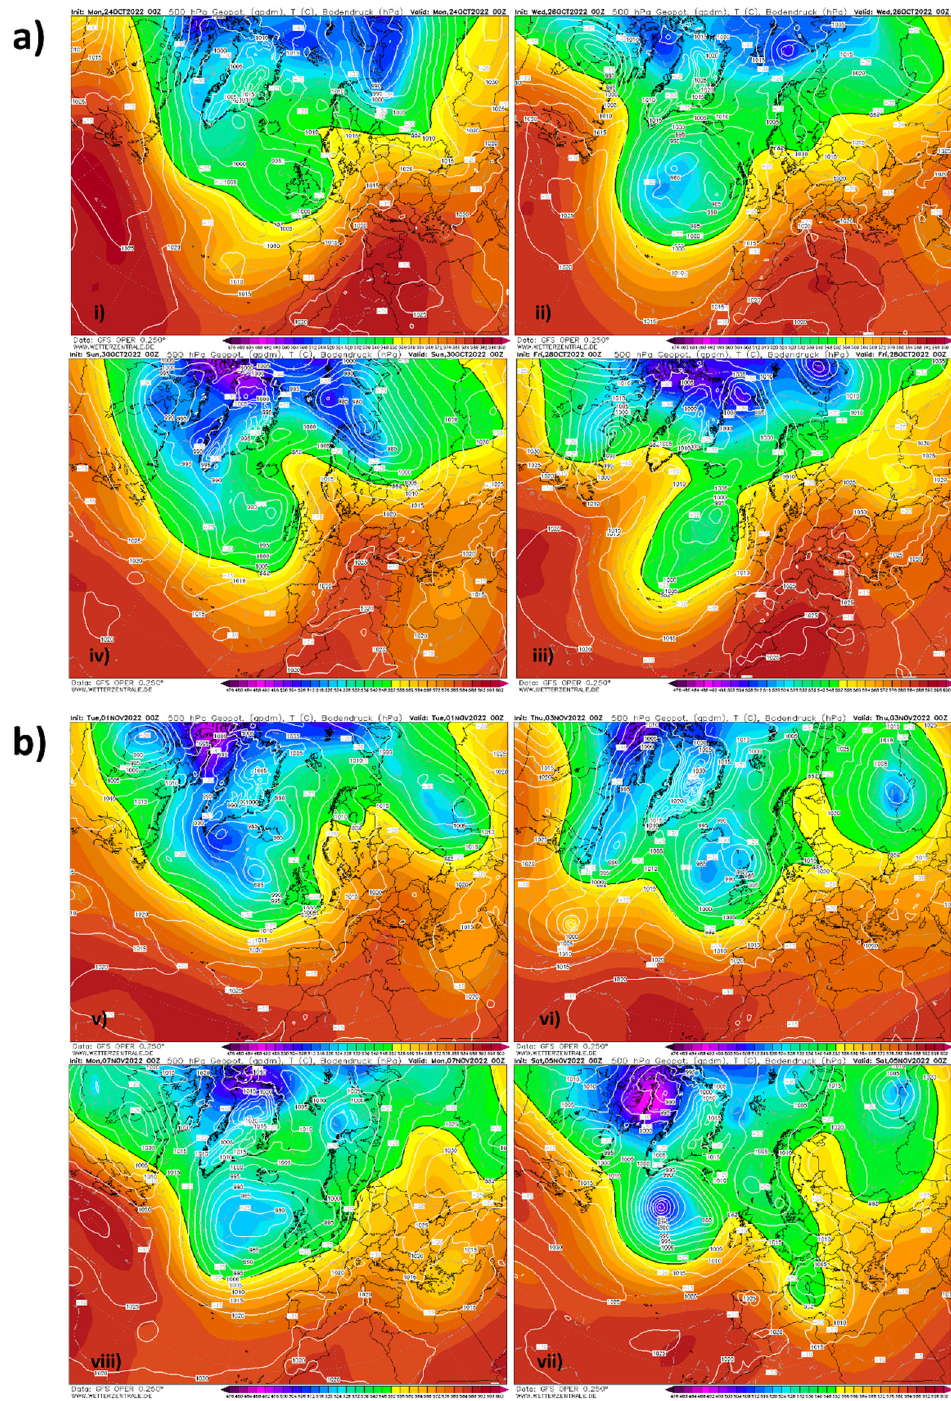
Figure 4. Weather conditions in the North Atlantic region corresponding to ( a ) the last decade of October 2022 (clockwise in the panel: ( i ) 24 October 2022; ( ii ) 26 October 2022; ( iii ) 28 October 2022; ( iv ) 30 October 2022) and ( b ) the first week of November 2022 (clockwise in the panel: ( v ) 1 November 2022; ( vi ) 3 November 2022; ( vii ) 5 November 2022; ( viii ) 7 October 2022) studied using the reanalysis maps of Wetterzentrale (www.wetterzentrale.de (accessed on 23 January 2023)) at 500 hPa.